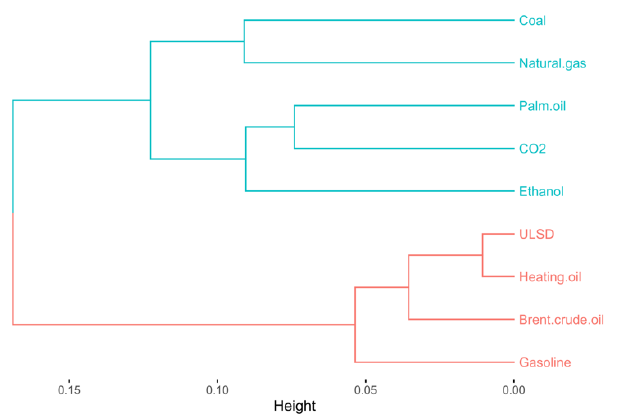
Figure 4. Dendrogram for hierarchical clustering of prices of commodities for the full period. Source: own elaboration on the basis of data from www.stooq.com (accessed on 19 April 2021).